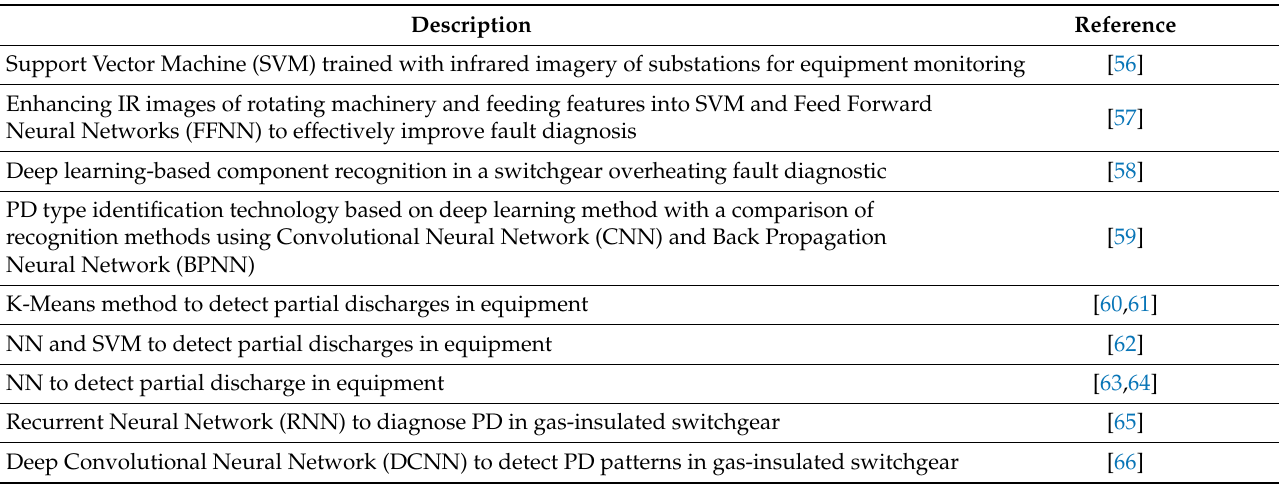
Table 1. AI utilization in switchgear